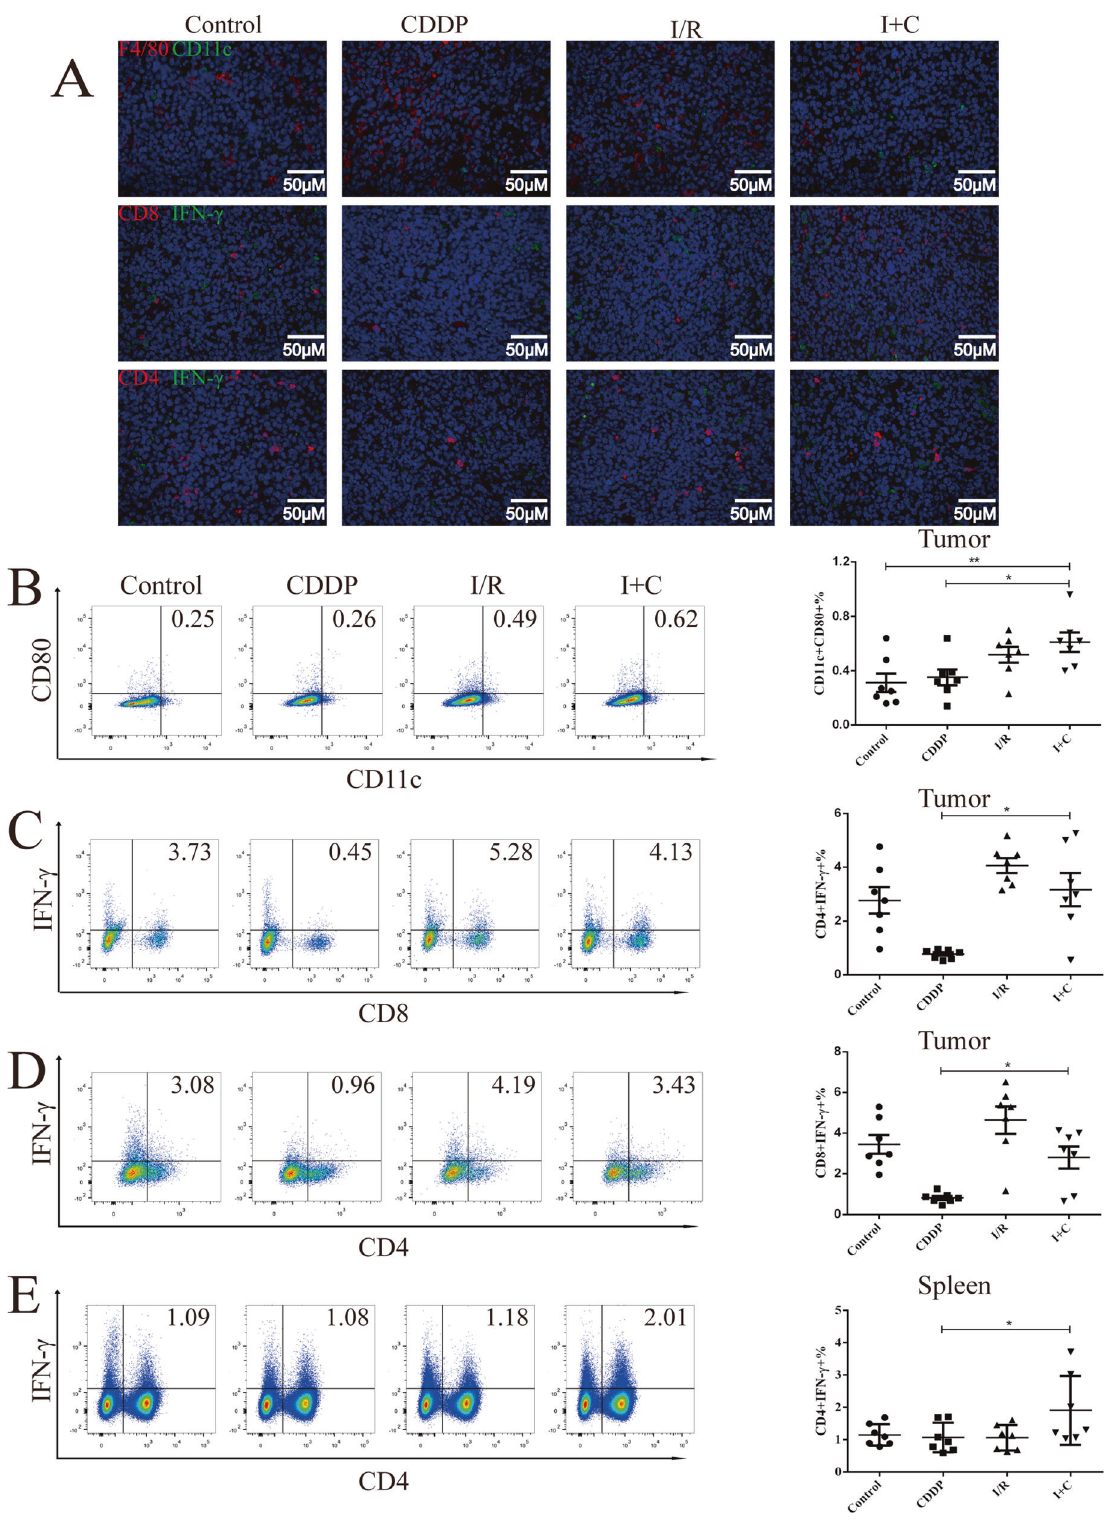
Fig. 6 Immune cell subsets of the tumor and spleen in mice. A Representative immuno fl uorescence images show the expression of CD8 (red), IFN- γ (greed), CD4 (red), F4/80 (red) and CD11c (green) in LLC tumors after different treatment. F4/80-CD80 + CD11c + cells B , IFN- γ + CD8 + T cells C , IFN- γ + CD4 + T cells D in the tumor were determined after gating on the live CD45 + cells. IFN γ + CD4 + T cells E in the spleen were determined after gating on the live cells. N = 7 for each group, each symbol represents a single mouse. Data are reported as the mean ± SEM, and statistical analyses were performed with one-way ANOVA followed by the Dunnett post hoc test B , E , Kruskal-Wallis followed by the Dunn post hoc test C , D . * P < 0.05 and ** P < 0.01.